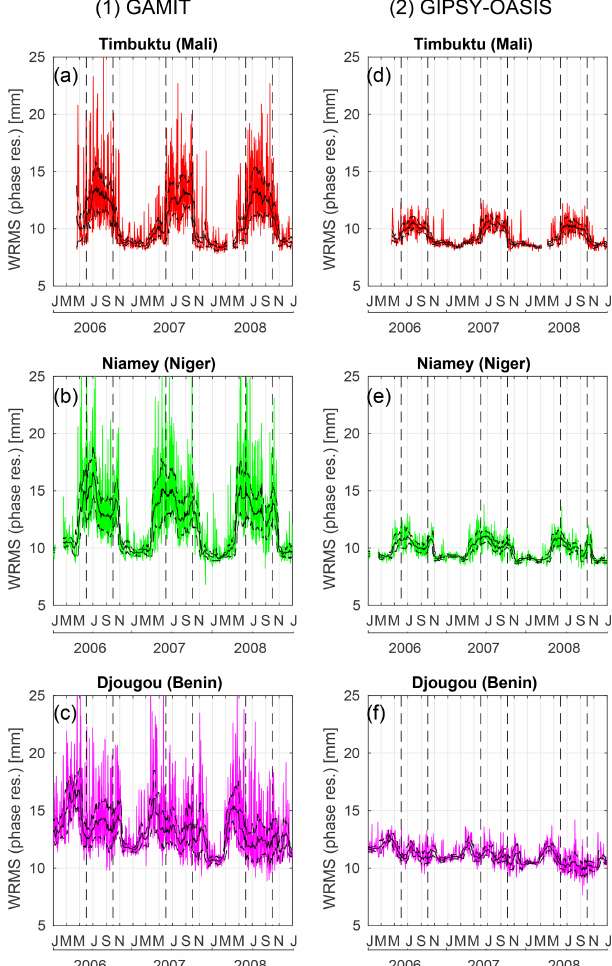
Figure 5. Daily weighted root mean square of the GPS post- fit phase residuals at (a, d) Timbuktu, (b, e) Niamey, and (c, f) Djougou. (a–c) Results of GAMIT software and (d–f) results of GIPSY-OASIS software. The solid black lines show 30d moving medians, and the dashed black lines show moving median absolute deviations around the